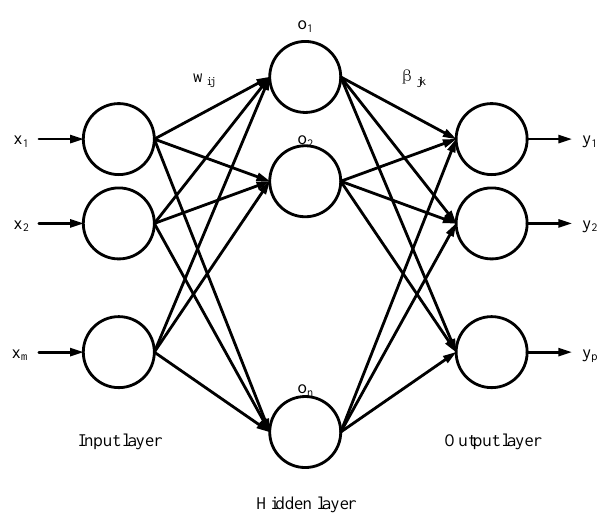
Figure 1. The structure of Extreme Learning Machine (ELM) model.